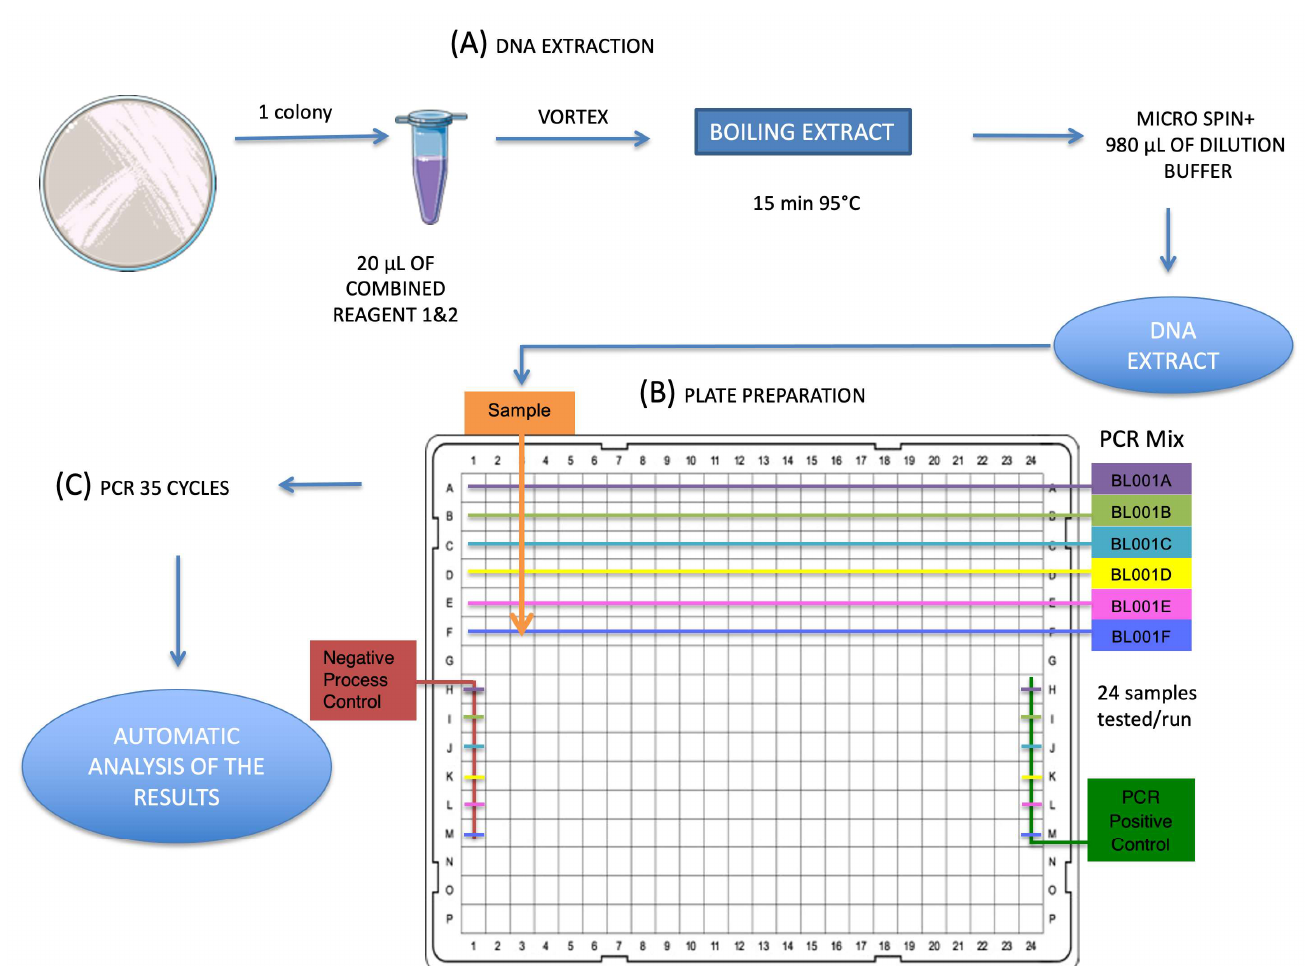
Figure 1. Experimental procedures. ( A ) Complete sample processing (lysis of any microorganisms present in one colony and conversion of all cytosine bases into uracil (detected as thymine after PCR amplification) with combined Reagent 1 and 2. ( B ) Two microliters of DNA extract together with sixteen microliters of PCR mixes was added to each well of the 384-well microplate. ( C ) Real-time PCR assay (EasyScreen™) on CFX384™. PCR amplification and result interpretation using